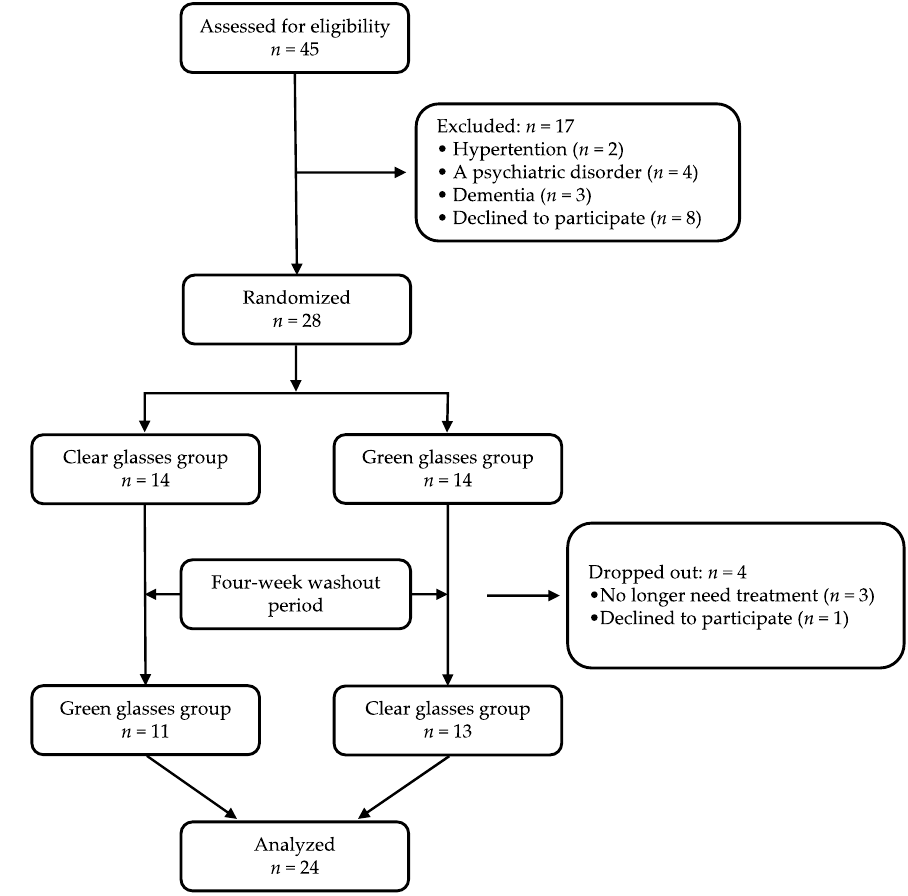
Figure 1. Study flow chart. Recruitment and allocation to study groups.